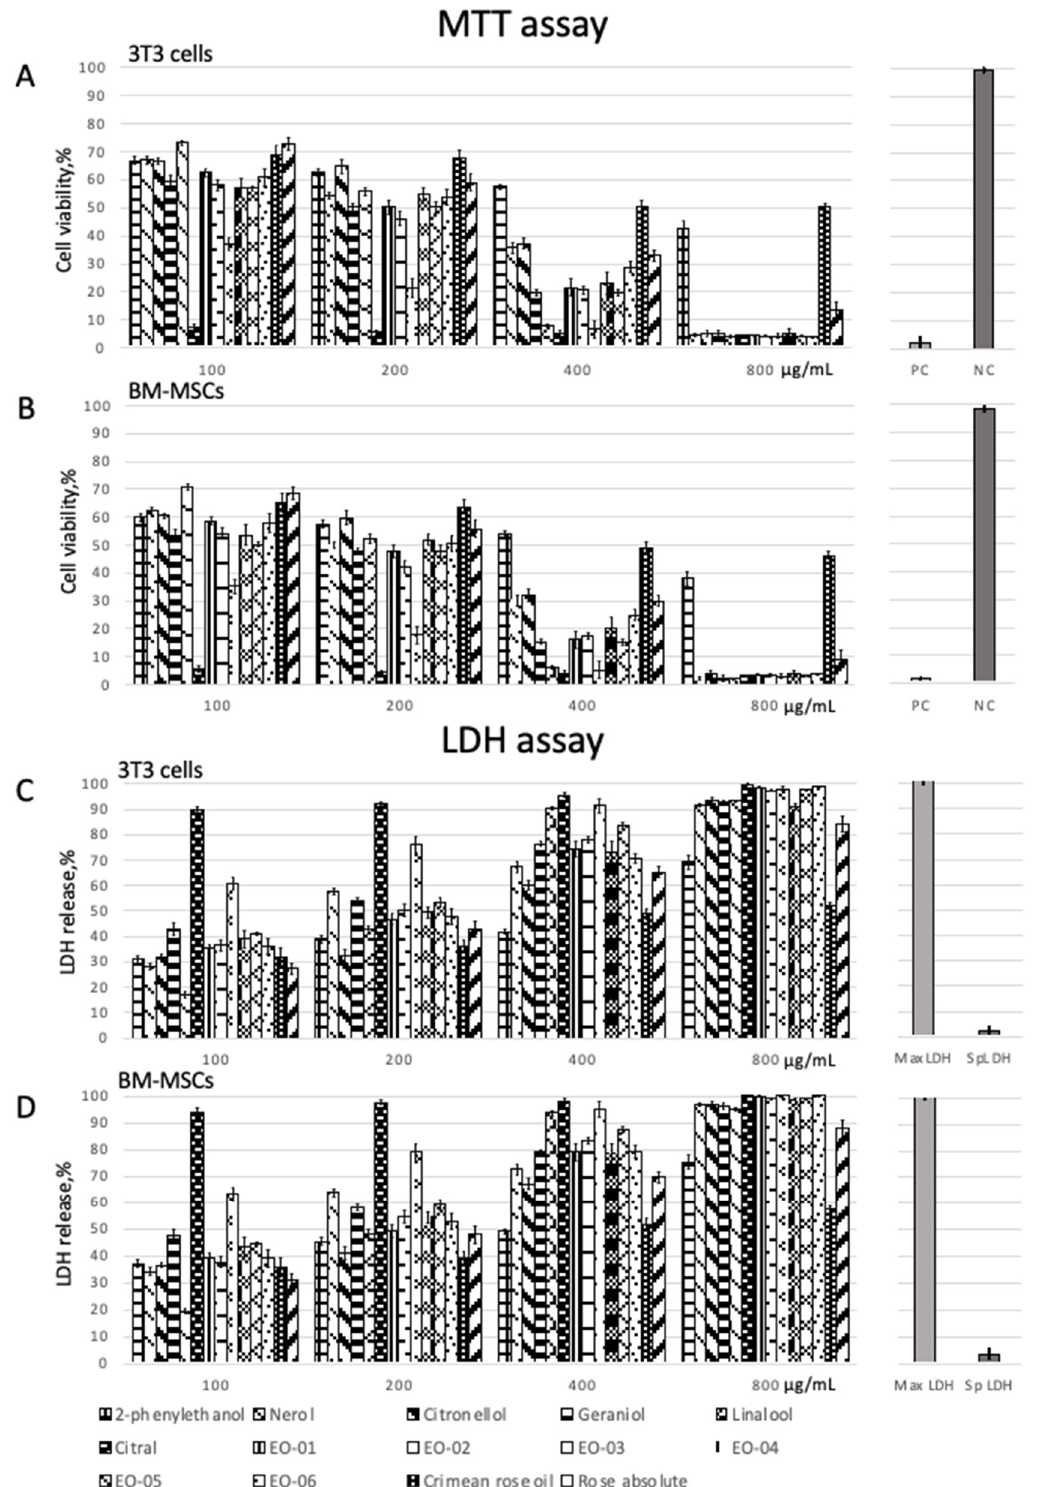
Figure 2. Viability of 3T3 cells ( A ) and BM-MSCs ( B ) treated with Eremothecium and rose oils, and their components (PC—positive control (SDS)); NC—negative control (non-treated cells). LDH release from 3T3 cells ( C ) and BM-MSCs ( D ) treated with Eremothecium and rose oils, and their components (MaxLDH—maximum LDH release (Triton X); SpLDH—spontaneous LDH release (non-treated cells)).